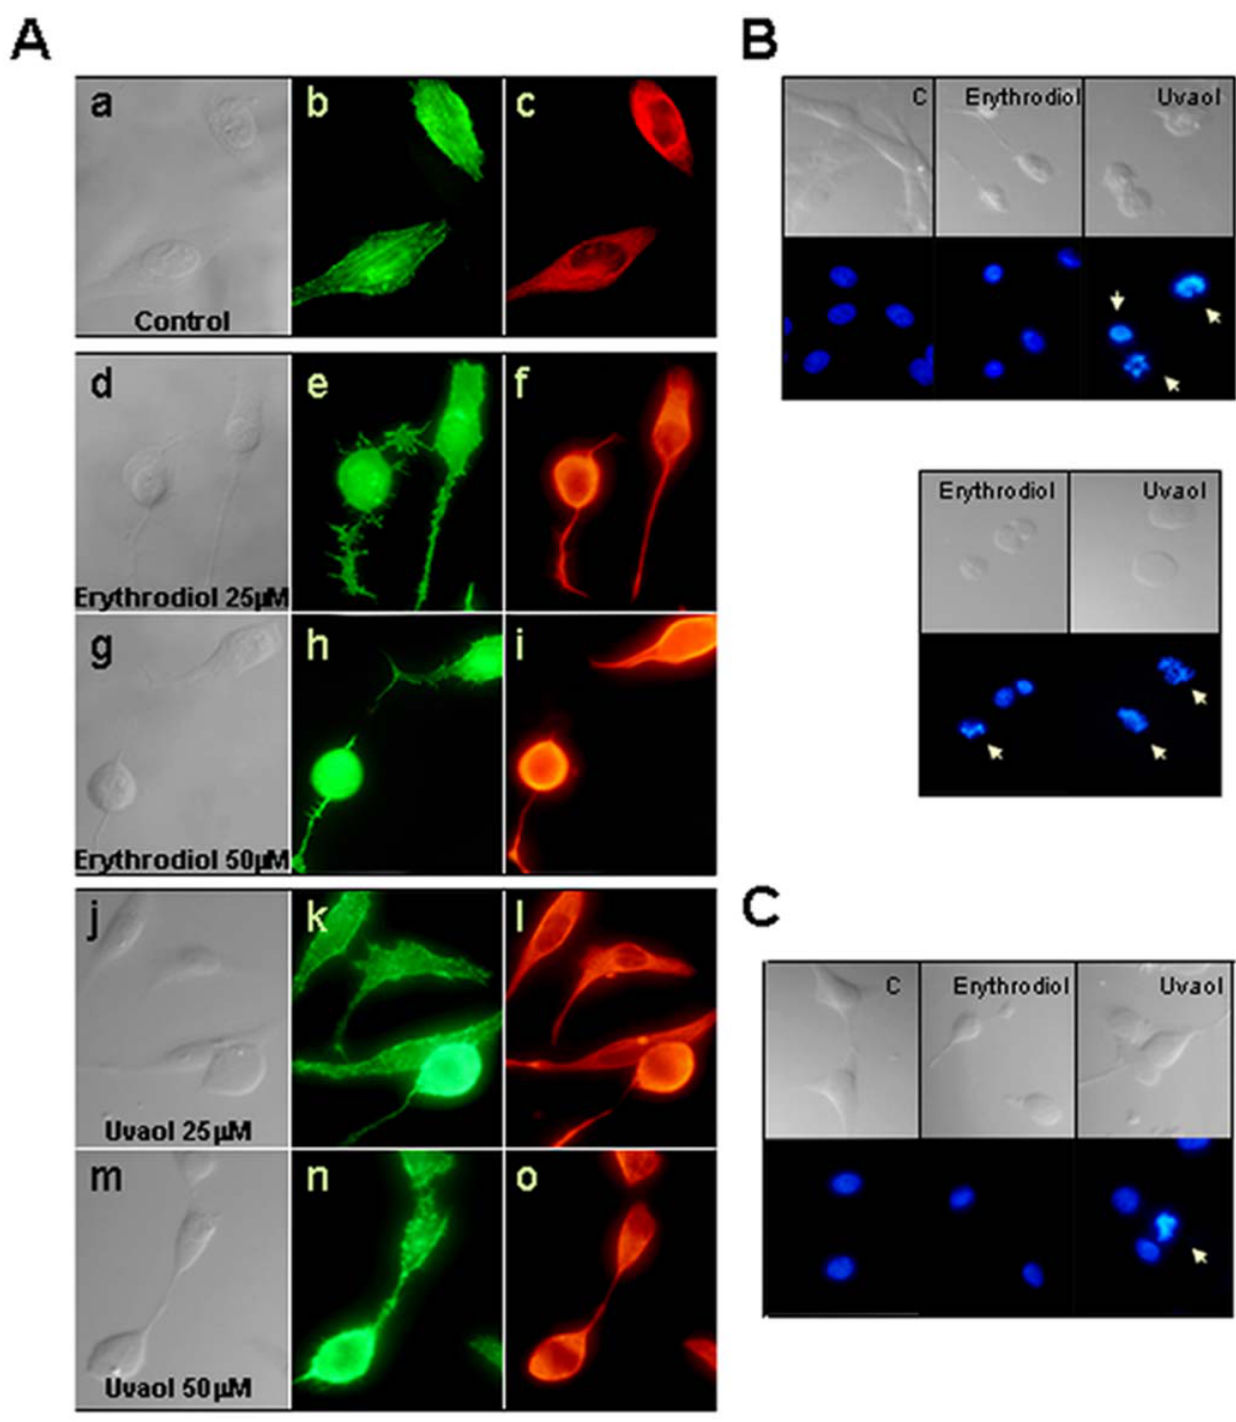
Figure 3. Erythrodiol and uvaol induce morphological changes in the cytoskeleton. A, Cells were treated with different doses of erythrodiol or uvaol for 6 h. Then, cells were stained with FITC-phalloidin (green, b, e, h, k and n) or anti-vimentin Ab (red, c, f, i, l and o) and visualized under a fluorescent microscope ( 6 60). Cells were seeded on standard conditions (B) or in poly- L -lysine treated coverslips (C). After 18 h of exposure to 25 m M of triterpenes, floating cells (B lower panels ) and attached cells (B upper panels and C) were fixed and stained with DAPI. Cells were visualized using a Nikon Eclipse 80i fluorescent microscope ( 6 60). The cellular morphology was observed using Nomarski optics. The floating population from the adherent condition was too low to be evaluated.